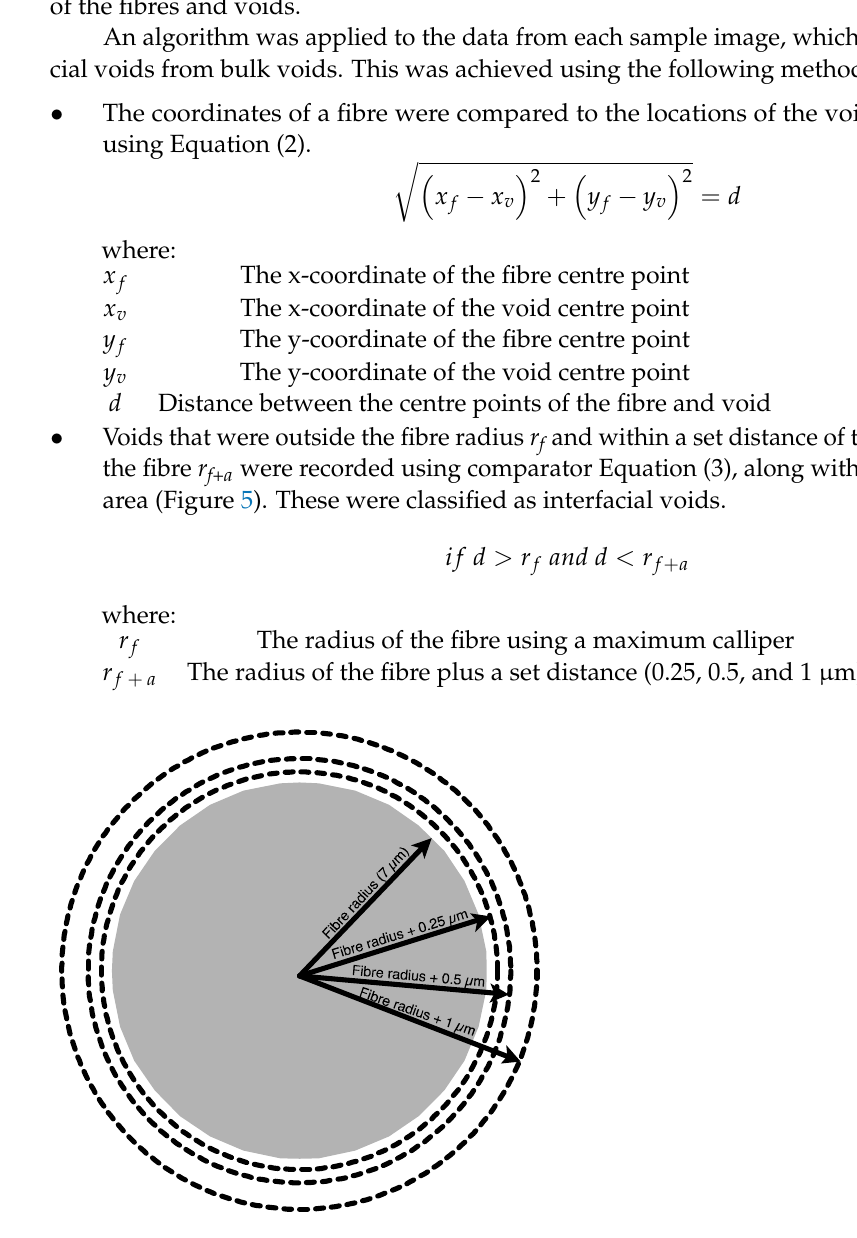
Figure 5. Boundary regions used to search for interfacial voids.